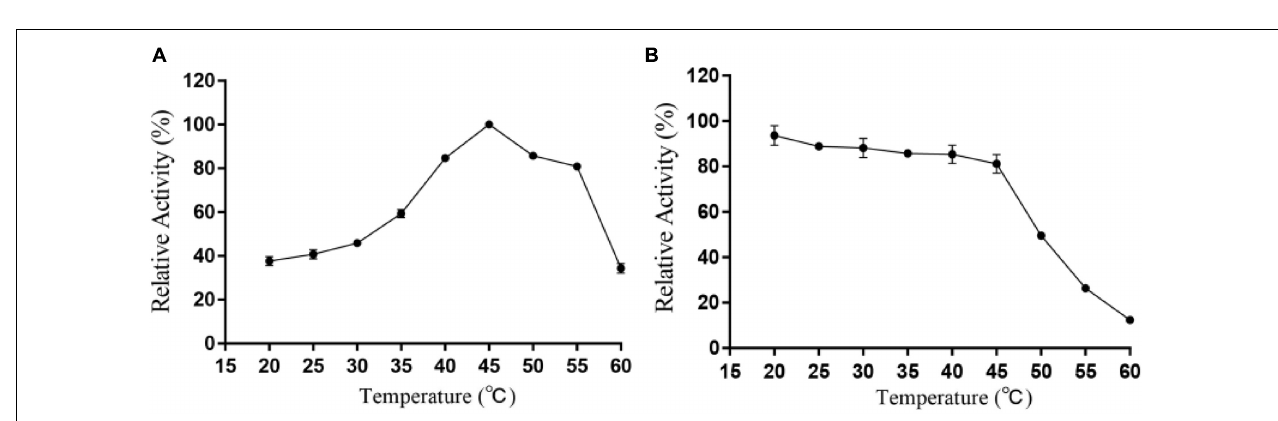
FIGURE 4 | Effect of pH on the activity (A) and stability (B) of Alyw203. Values are expressed as mean ± standard deviation (SD), n = 3.